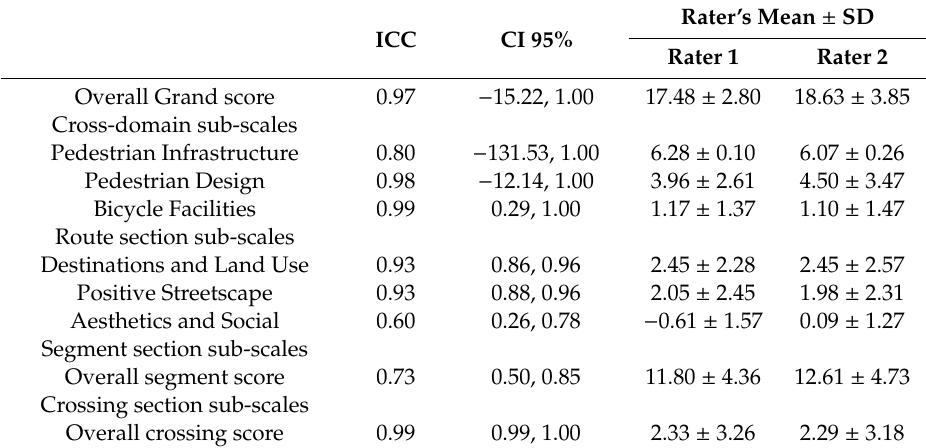
Table 2. Inter-rater reliability of MAPS Global sub-scales and